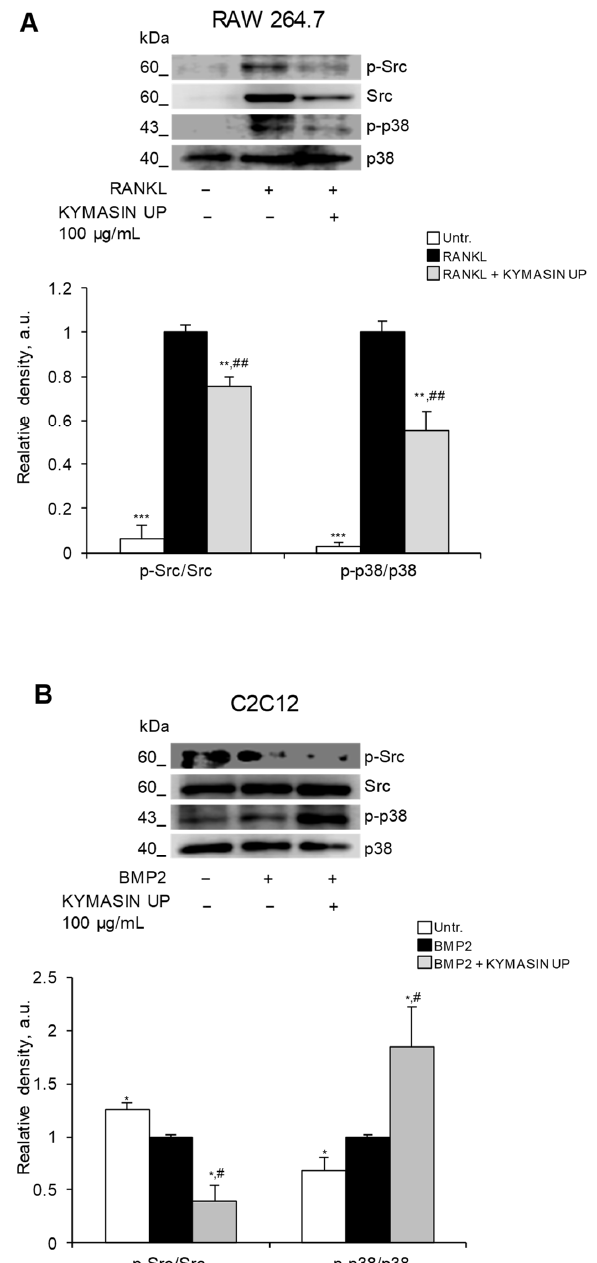
Figure 7. ( A , B ) The expressions of phosphorylated (p) Src (non-receptor tyrosine kinase) and p38 MAPK (p38 mitogen-activated protein kinase) were analyzed by Western blotting in RAW 264.7 cells treated with RANKL for 5 days ( A ) or in C2C12 cells treated with BMP2 for 6 days ( B ), in the absence or presence of KYMASIN UP (100 µg/mL). Representative images and the relative densities with respect to the total forms of Src and p38 are reported. Results are means ± standard error of the mean. Six ( A , B ) independent experiments were performed. Statistical analysis was conducted using the two-tailed t -test. * p < 0.05, ** p < 0.01, and *** p < 0.001, significantly different from RANKL ( A ) or BMP2 (B). # p < 0.05, and ## p < 0.01, significantly different from untreated control (Untr).